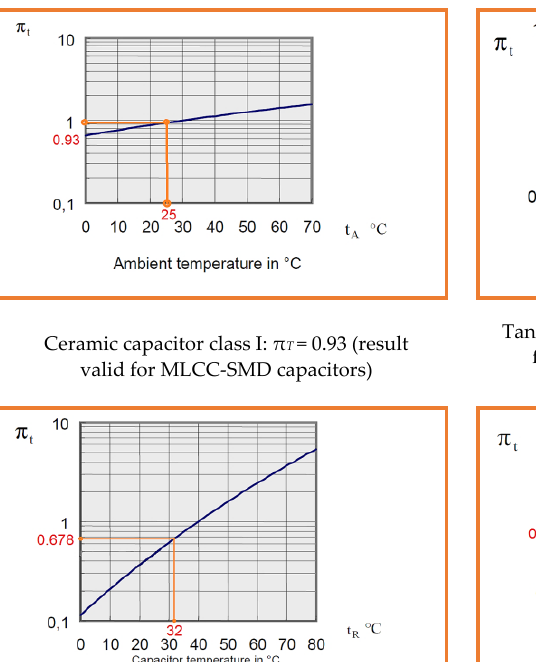
Table 1. Calculated parameters π T and Δ T i function of capacitor’s technology .